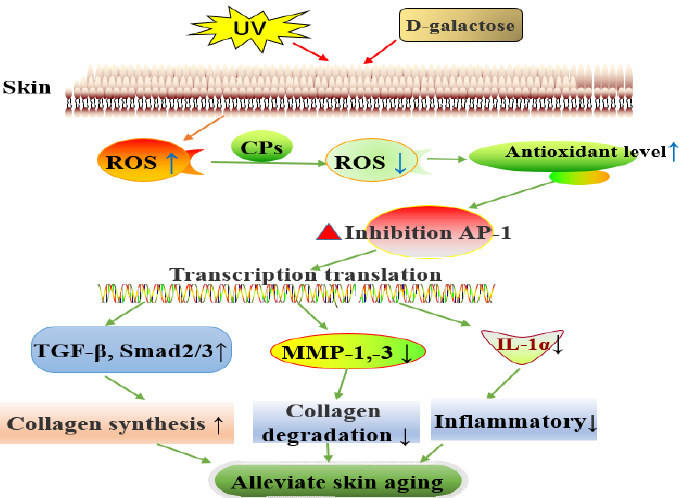
Figure 8. Biological pathways of dietary CPs to alleviate skin aging. “ ↑ ” means promote or increase; “ ↓ ” means inhibition or decrease.